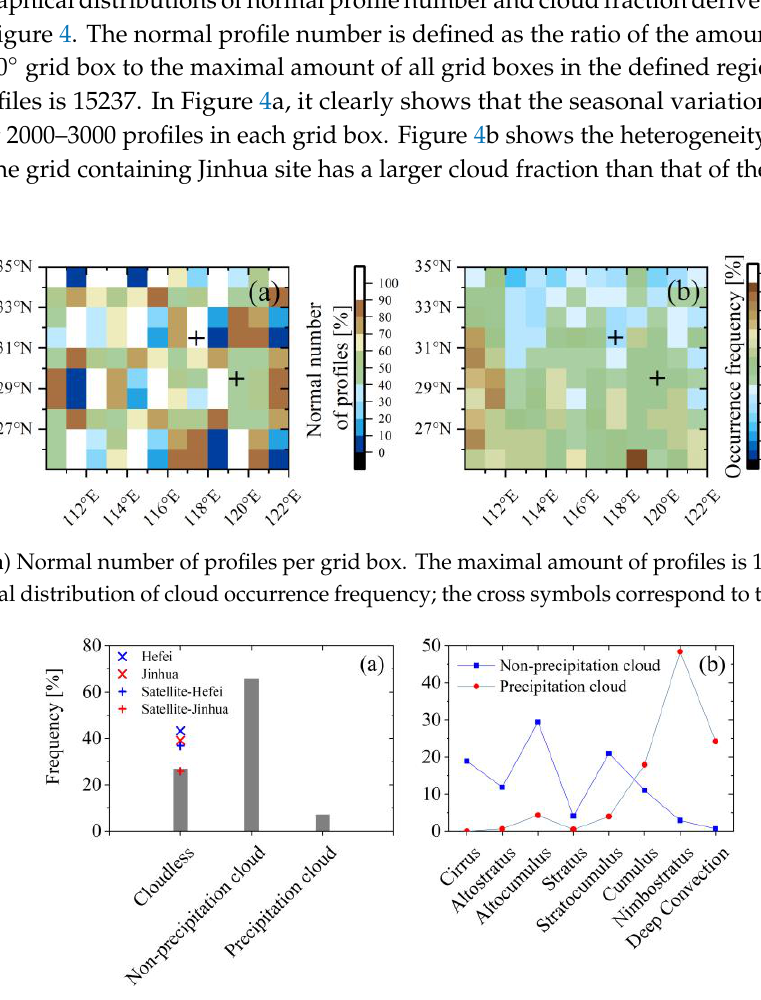
Figure 4. (a) Normal number of profiles per grid box. The maximal amount of profiles is 15237; (b) The geographical distribution of cloud occurrence frequency; the cross symbols correspond to the lidar sites.